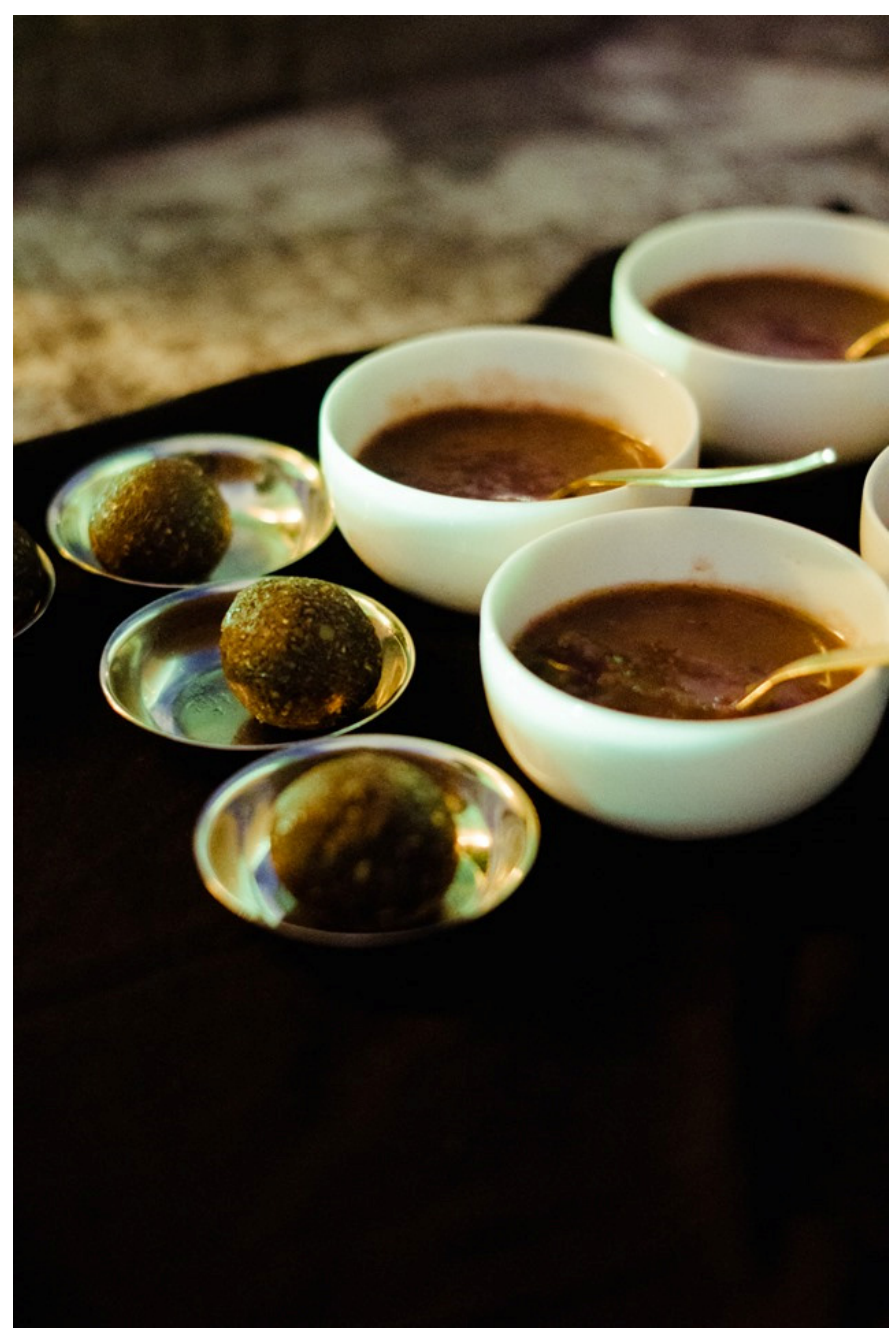
Figure 5. Place of Supper . Sleeping bonbons and cherry purée, by chef Annick Gernaey, offered to the visitors. Mãe d’Água das Amoreiras Reservoir, Lisbon, 2019. © Joana Linda.